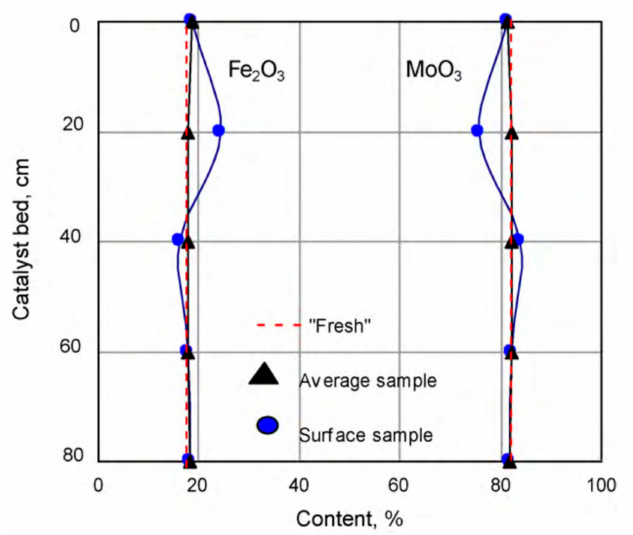
Figure 13. Catalyst composition measured by ICP along the catalyst bed in reactor with good heat transfer. Reprinted from [82] Copyright © (2010) with permission from